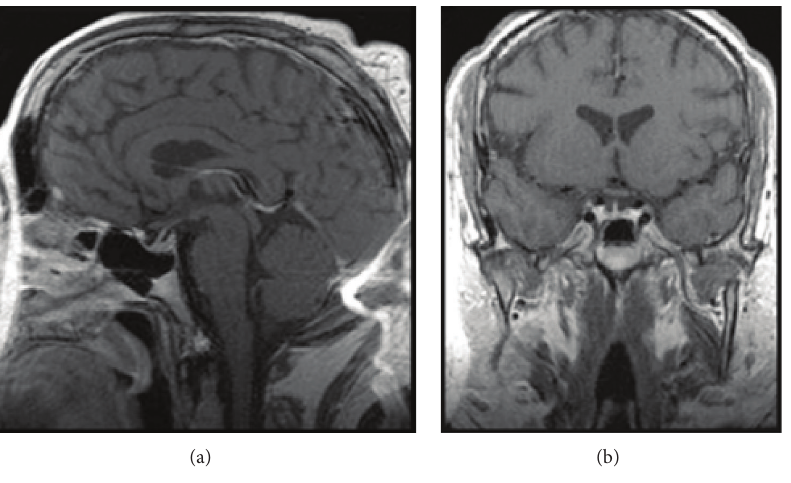
Figure 2: Postoperative MRI at 2 years